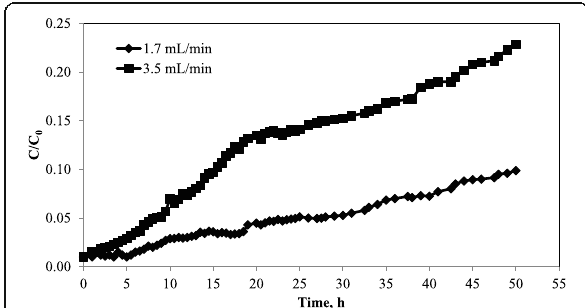
Fig. 10 Flow rate effect on breakthrough time in the fixed-bed column study using fresh